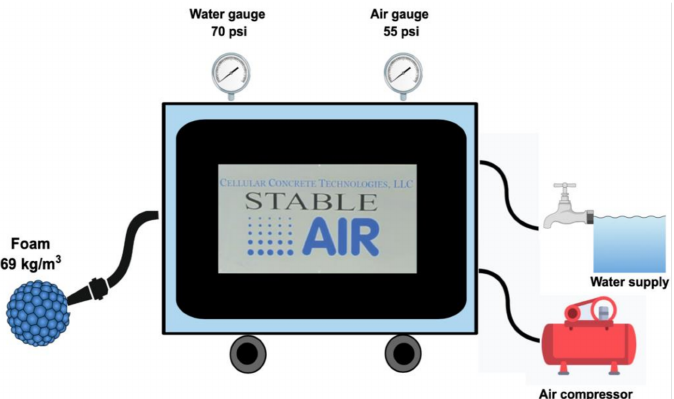
Figure 4. Schematic diagram of foam generation using the Stable